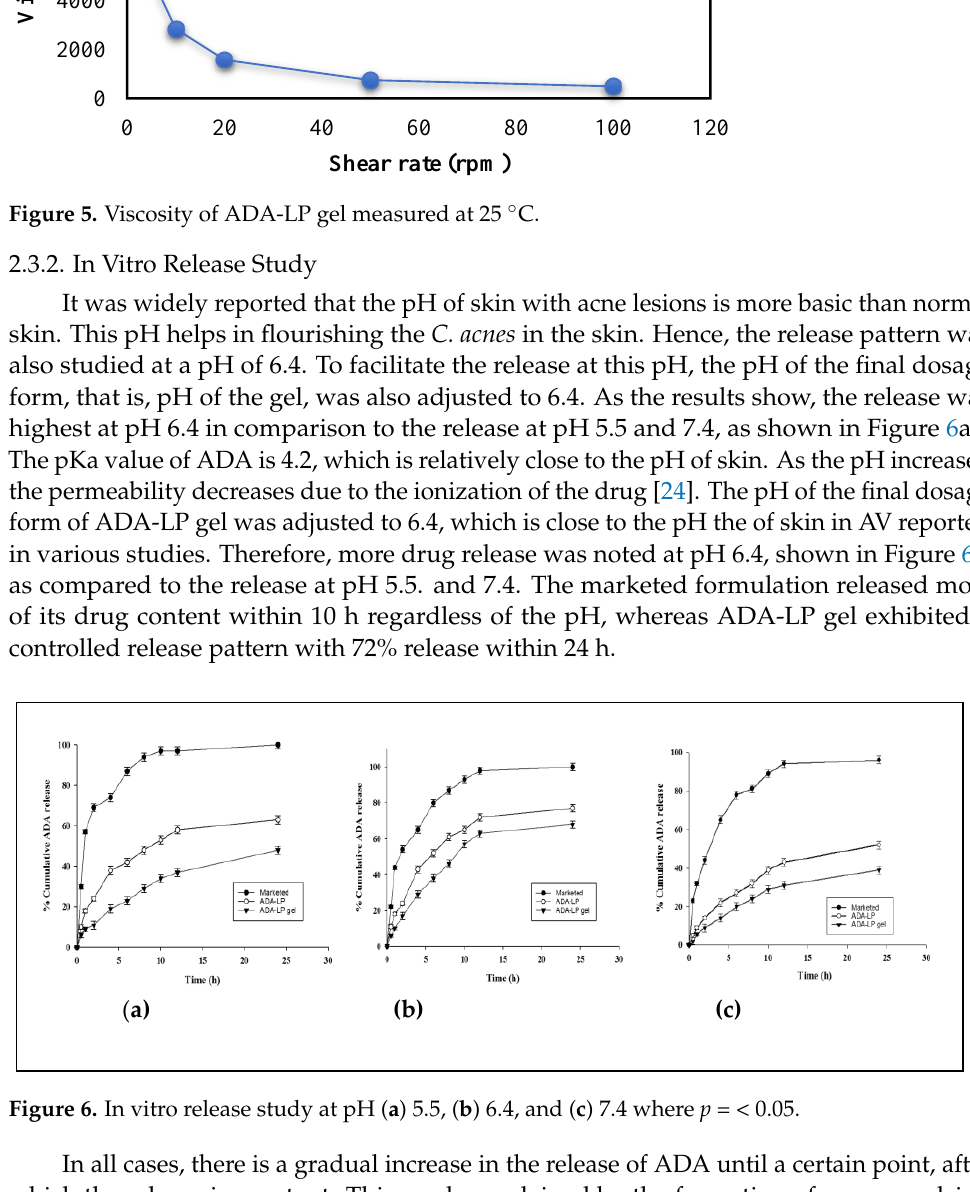
Figure 6. In vitro release study at pH ( a ) 5.5, ( b ) 6.4, and ( c ) 7.4 where p = <